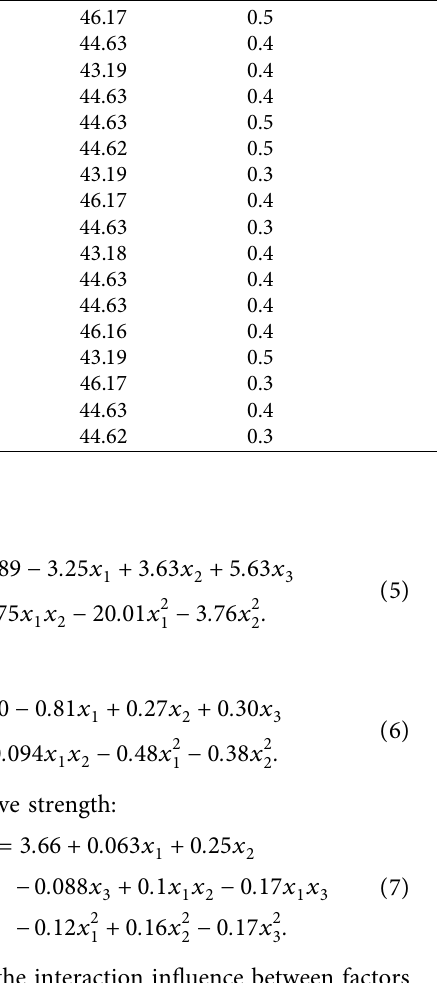
Wet fly ash Samples (wt.